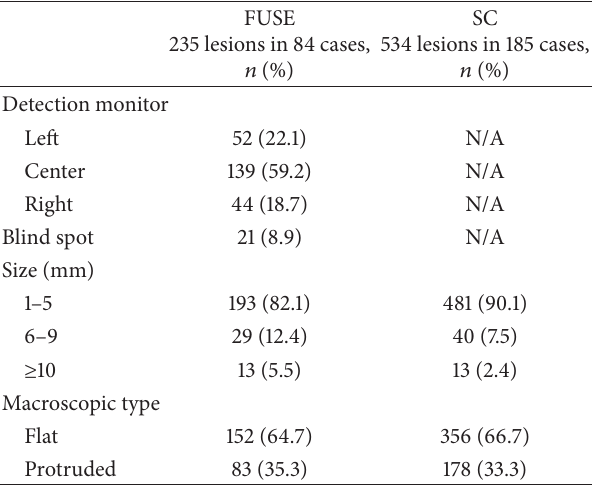
Table 3: Outcomes of endoscopists’ evaluations on the usability of